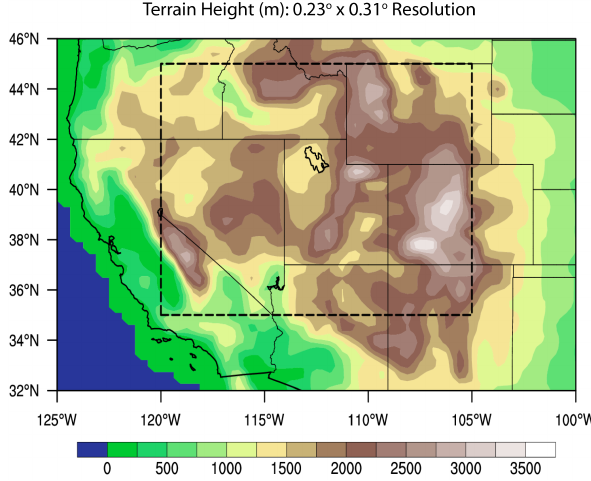
Figure 1. The elevation map over a 0.23 ◦ × 0.31 ◦ resolution grid for the Rocky–Sierra areas in the western United States. The box on the map displays major mountainous areas for which simulation results are analyzed and presented in the